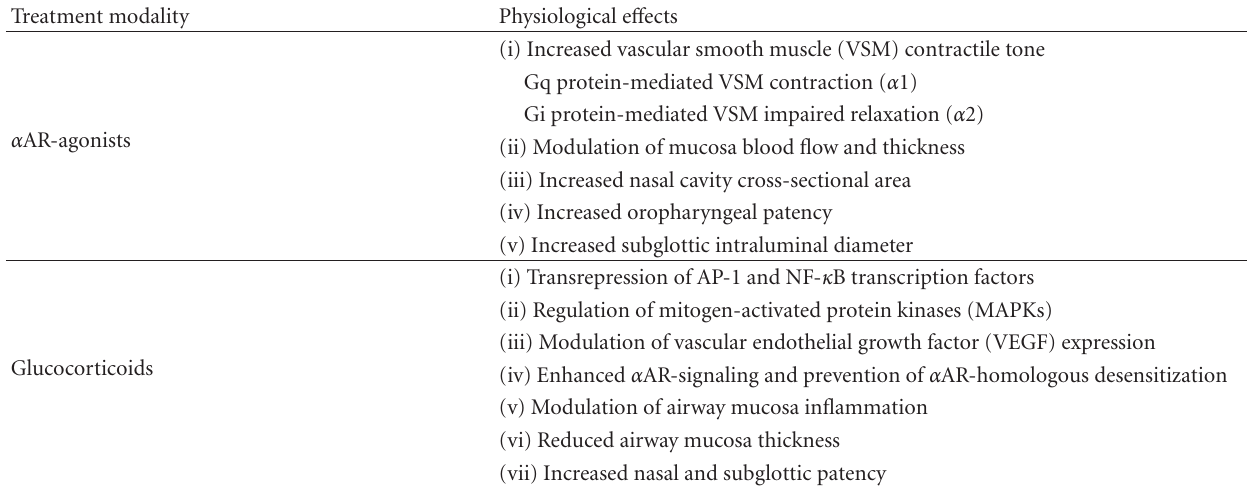
Table 1: Molecular and cellular e ff ects of α AR-agonists and glucocorticoids in the upper